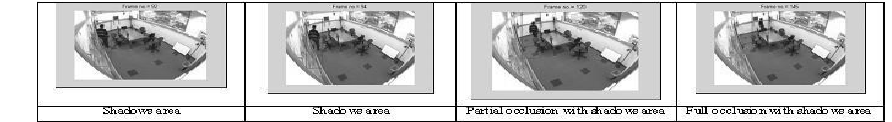
Figure 7. Video under shadow and occlusion.